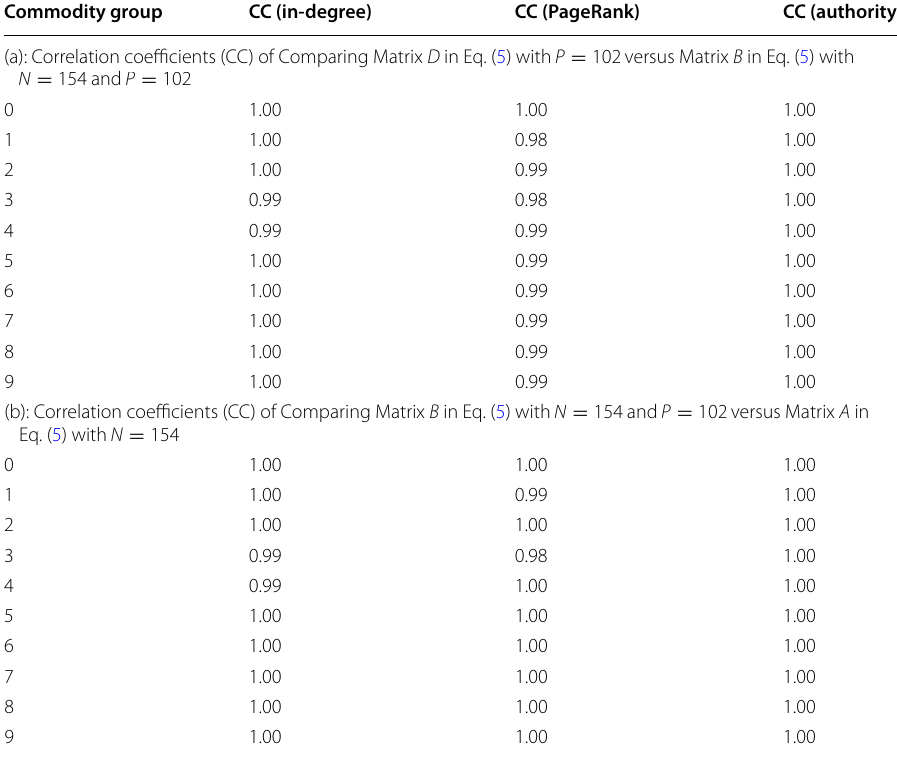
Table 4 Correlation coefficients between the rank of 154 countries in full 154-country network and reduced 154-country network [part (a)], and correlation coefficients between the rank of 102 countries in reduced 154-country network and 102-country network [part (b)] based on centrality measures in import